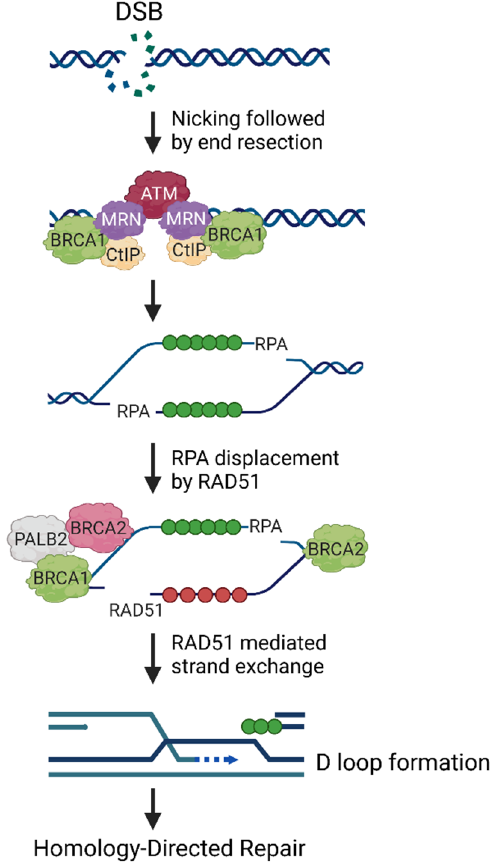
Figure 1. Role of BRCA1 in DNA double-strand break repair. Homology-directed repair or homol- ogous recombination is an error-free repair pathway of DNA double-strand breaks (DSBs), which occurs primarily during S/G2 cell cycle phases. ATM is a serine/threonine protein kinase that is recruited to and activated at the DNA damage sites by the MRE11, RAD50, and NBS1 (MRN) complex. Upon activation, ATM phosphorylates a large number of substrates to promote DNA repair. DNA end resection is the initial step in determining the DSB repair choice and is controlled by BRCA1, MRN, and CtIP. The replication protein A (RPA) binds to single-stranded DNA after the end resection. BRCA1 promotes the recruitment of PALB2 and BRCA2 at DNA-damage sites, and the interaction between BRCA1 and PALB2 is important for the HR repair pathway. BRCA1-PALB2-BRCA2 complex leads to the formation of RAD51 filaments on the 3’ single-stranded DNA, followed by the strand invasion into a homologous DNA, initiating the formation of displacement loops (D-Loops), which leads to the resolution of DSBs. Created with Biorender.com.